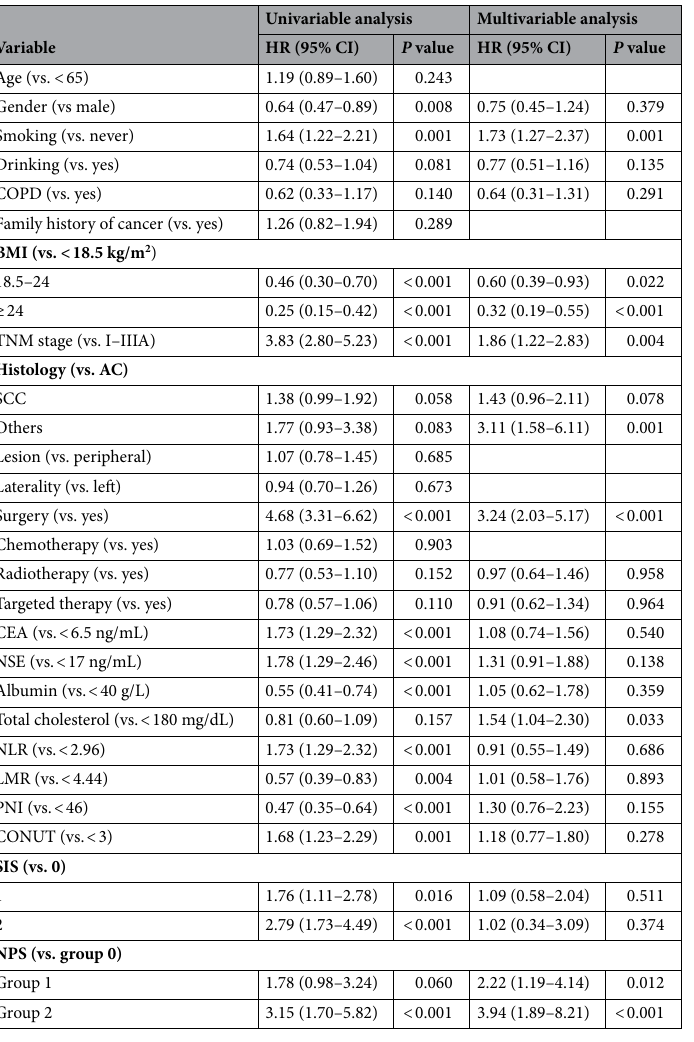
Table 4. Univariable and multivariable analysis of progression-free survival in NSCLC patients. AC adenocarcinoma, BMI body mass index, CEA carcinoembryonic antigen, CI confidence interval,